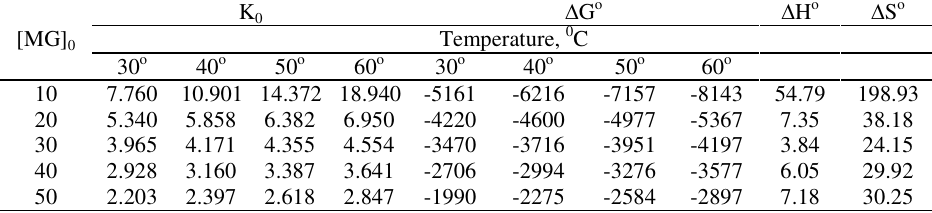
Table 6. Equilibrium constant and thermodynamic parameters for the adsorption of malachite green onto activated